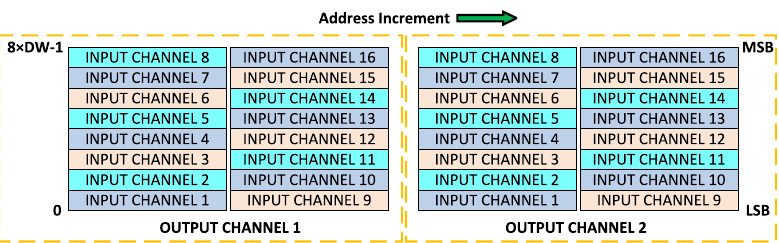
Figure 6. Computational kernel data remapping.